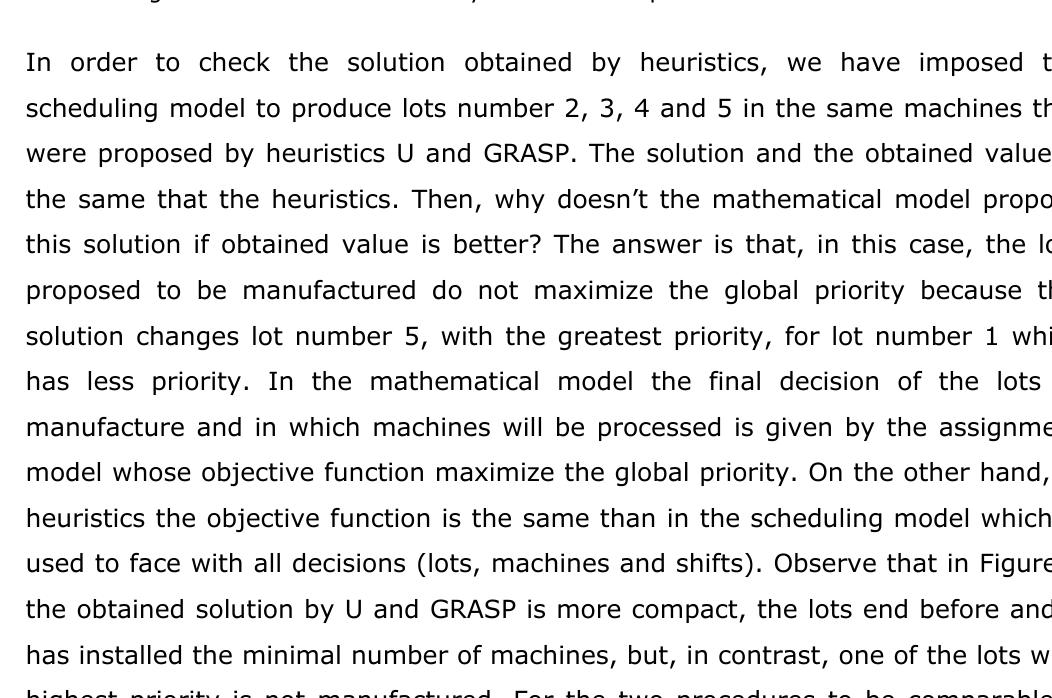
Figure 6. “Solution obtained by GRASP and U procedures”. Source: